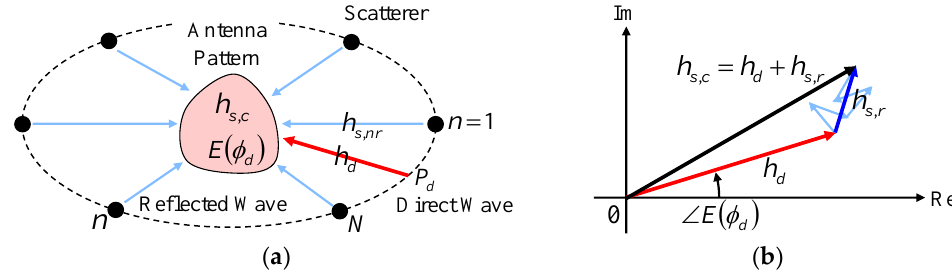
Figure 9. Channel model dependent multipath characterization: ( a ) Rice channel model and ( b ) vector diagram.